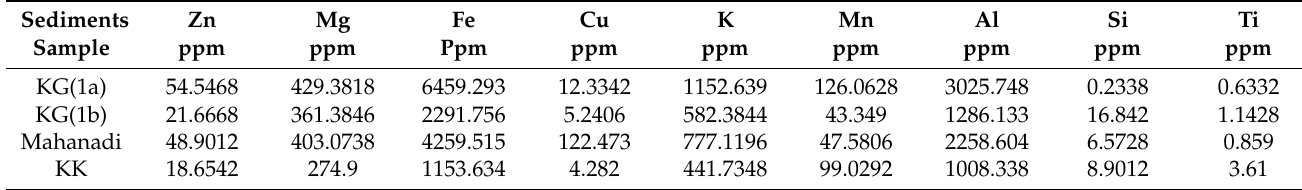
Table 8. Chemical analysis of sediment samples.